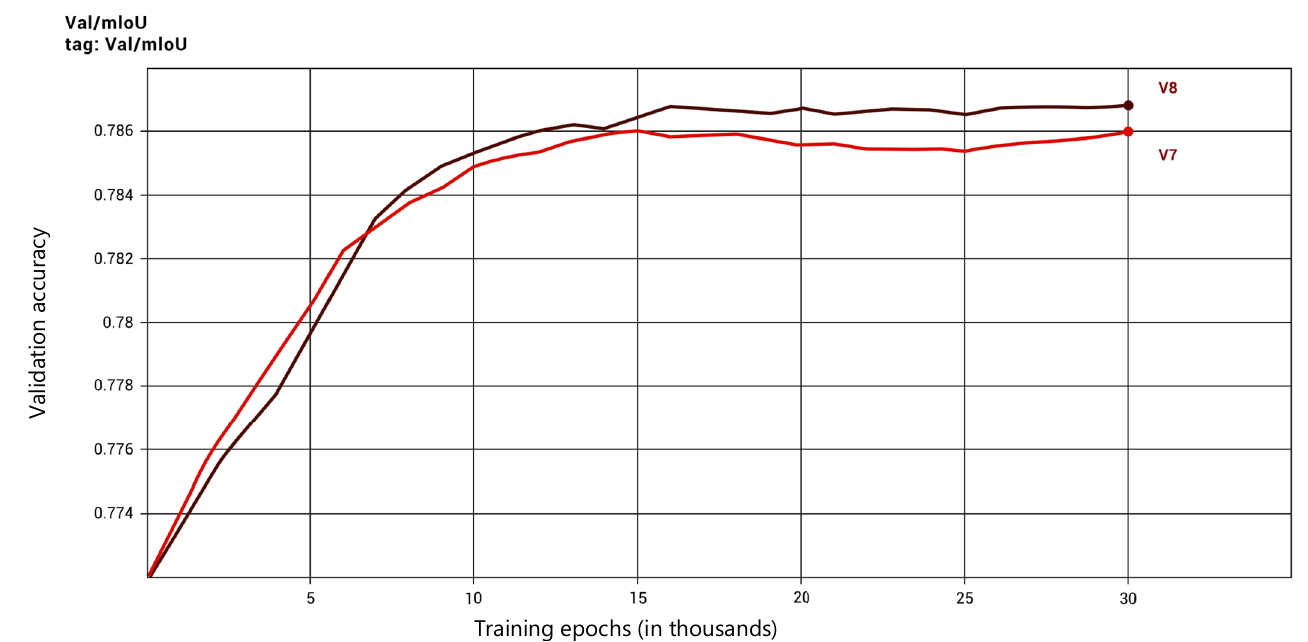
Figure 9. NAS-MACU-V7 and NAS-MACU-V8 comparison by validation accuracy.